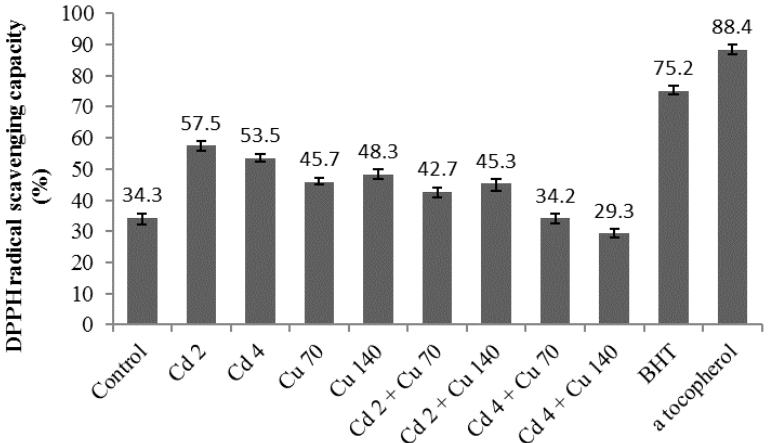
Figure 2. The impact of cadmium and copper on DPPH radical scavenging activity of G. procumbens . Bars represents standard error of differences between the means. N = 15. Cd 2 = cadmium 2 mg/L; Cd 4 = cadmium 4 mg/L; Cu 70 = copper 70 mg/L; Cu 140 = copper 140 mg/L; Cd 2 + Cu 70 = cadmium 2 mg/L + copper 70 mg/L; Cd 2 + Cu 140 = cadmium 2 mg/L + copper 140 mg/L; Cd 4 + Cu 70 = cadmium 4 mg/L + copper 70 mg/L; Cd 4 + Cu 140 = cadmium 4 mg/L + copper 140 mg/L.